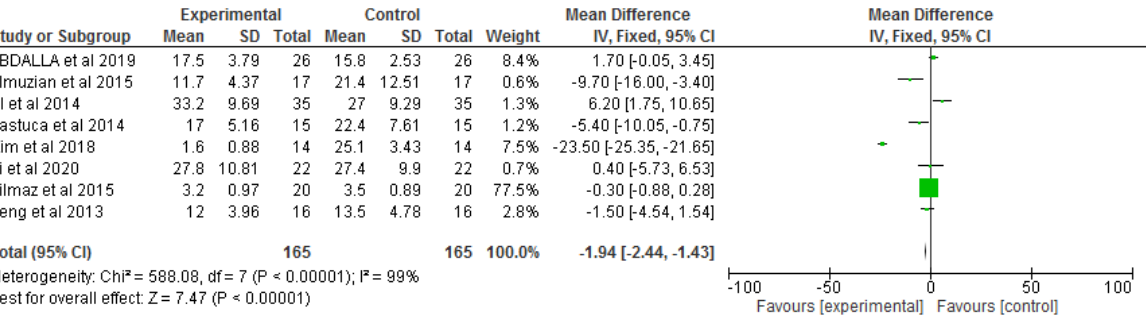
Figure 10. Forest plot for maxillary expansion between experiment and control.